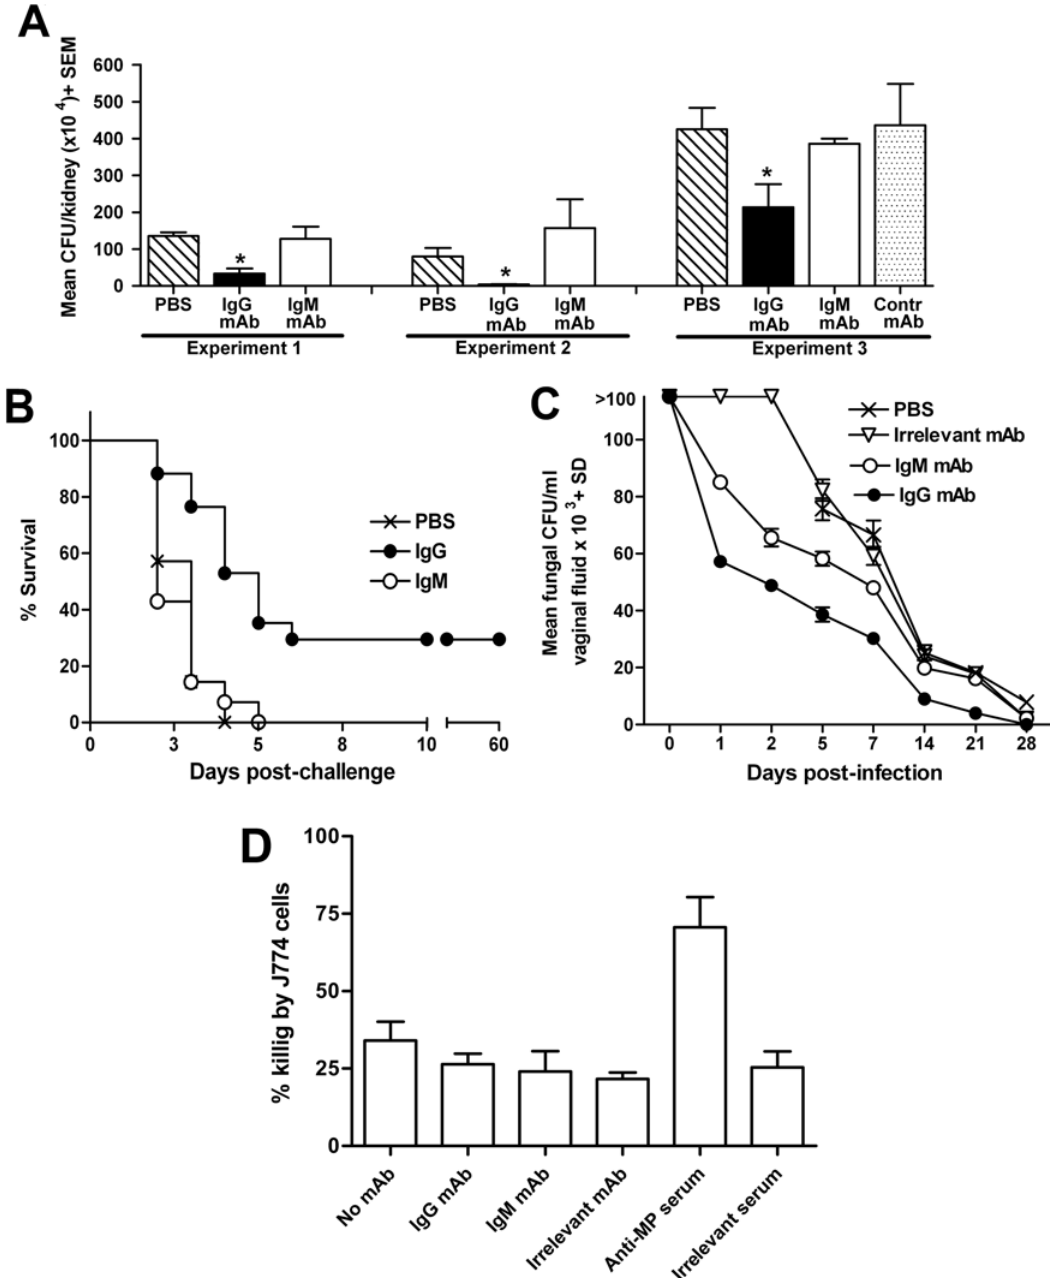
Figure 2. Protection by anti- b -glucan mAbs. Panel A : Fungal burden in kidney following a systemic infection with C. albicans in anti- b -glucan mAb-treated mice. In each of these experiments, groups of three mice were passively immunized by the i.p. route with 100 m g/0.5 ml of the IgG or IgM anti- b -glucan mAb, as indicated whereas control mice (three per group) received 0.5 ml of PBS only (Experiments 1 and 2) or 100 m g/0.5 ml of an irrelevant IgG2b mAb (Experiment 3). Two hours post passive immunization, the animals were infected i.v. with C. albicans (5 6 10 5 , Exp 1 and 2 or 10 6 cells/mouse, Exp 3) and extent of fungal invasion was evaluated at day 2 post-challenge thruogh CFU enumeration in left kidney. The asterisks indicate a statistically significant difference (P , 0.05) in mean CFU number/kidney in the corresponding group of animals as compared to the PBS- treated (experiments 1 and 2) or to the irrelevant mAb-treated group (experiment 3). Panel B: Survival of mice given a single, prophylactic administration of the anti- b -glucan mAbs and lethally infected with C. albicans . Mice (7 per group) were administered a single dose of the indicated mAb (150 m g/0.5 ml, i.p.) or 0.5 ml of PBS and, 2 h later, received a lethal challenge with C. albicans (10 6 cells/mouse, i.v.). Log rank test indicated statistically significant differences between survival curves of PBS- and IgG- and between those of IgG- and IgM-treated animals, but no significant difference between PBS- and IgM- treated mice. Panel C: Protection by the anti- b -glucan mAbs in a rat model of vulvovaginal candidiasis. The graph shows kinetics of fungal clearance from the vagina (mean + SE values of C. albicans CFU in vaginal fluids at the indicated times post-infection) in oophorectomized, estrogen-treated rats (five per group) intravaginally infected with C. albicans and treated with the anti- b -glucan mAbs or with an irrelevant mAb (40 m g/200 m l at 1, 24 and 48 hours post-infection) or with PBS alone (200 m l, same schedule). The experiment was repeated twice with similar results. Panel D: Evaluation of the opsonic activity of the mAbs. C. albicans killing by J774 murine macrophages was assessed by a classical CFU count after 3 h of contact (MOI 0.2:1) in the absence or in the presence of the indicated anti- b -glucan mAb (1 m g/well) or an opsonizing anti- C.